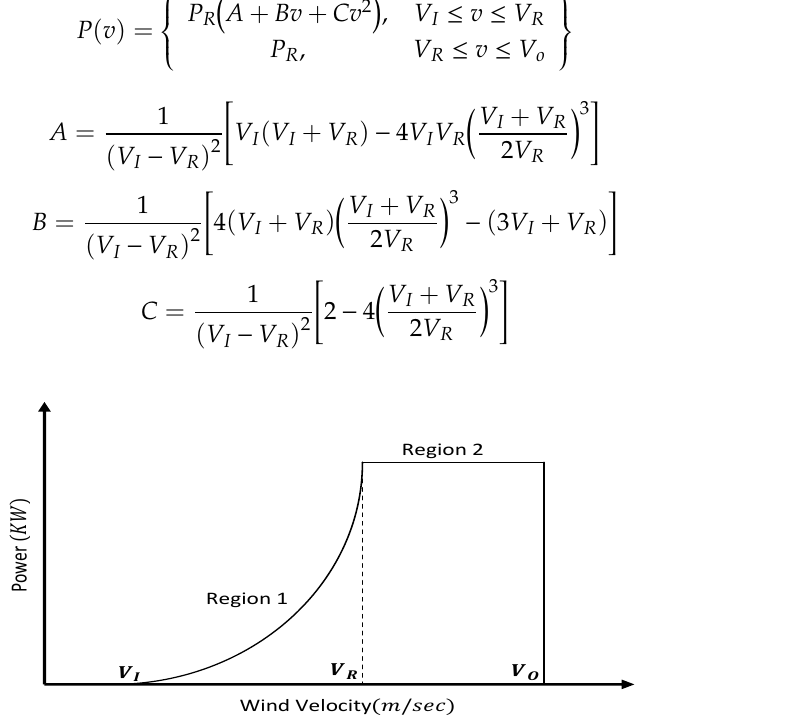
Figure 4. Schematic of wind turbine output power model.